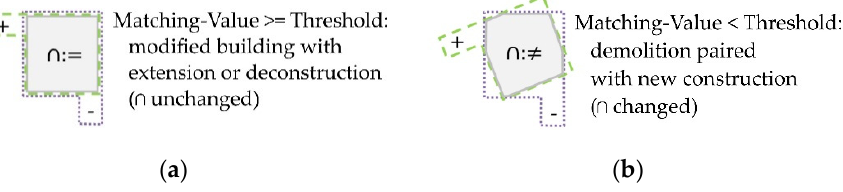
Figure 6. Schematic examples of a modified building and a replaced building: ( a ) modified building with unchanged intersection area; ( b ) replaced building with changed intersection area.